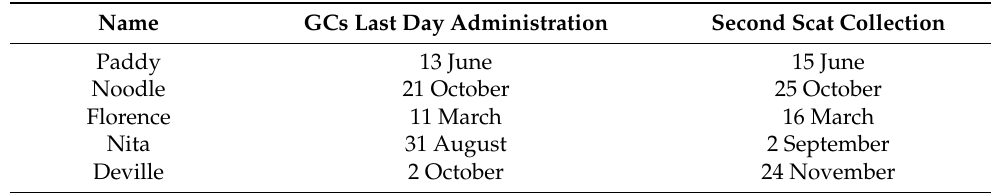
Table A4. Summary statistics for FCM (faecal cortisol metabolite) values (ng/g) measured by 50c and cortisol EIAs (enzyme immunoassays) for the control, diseased and injured groups.